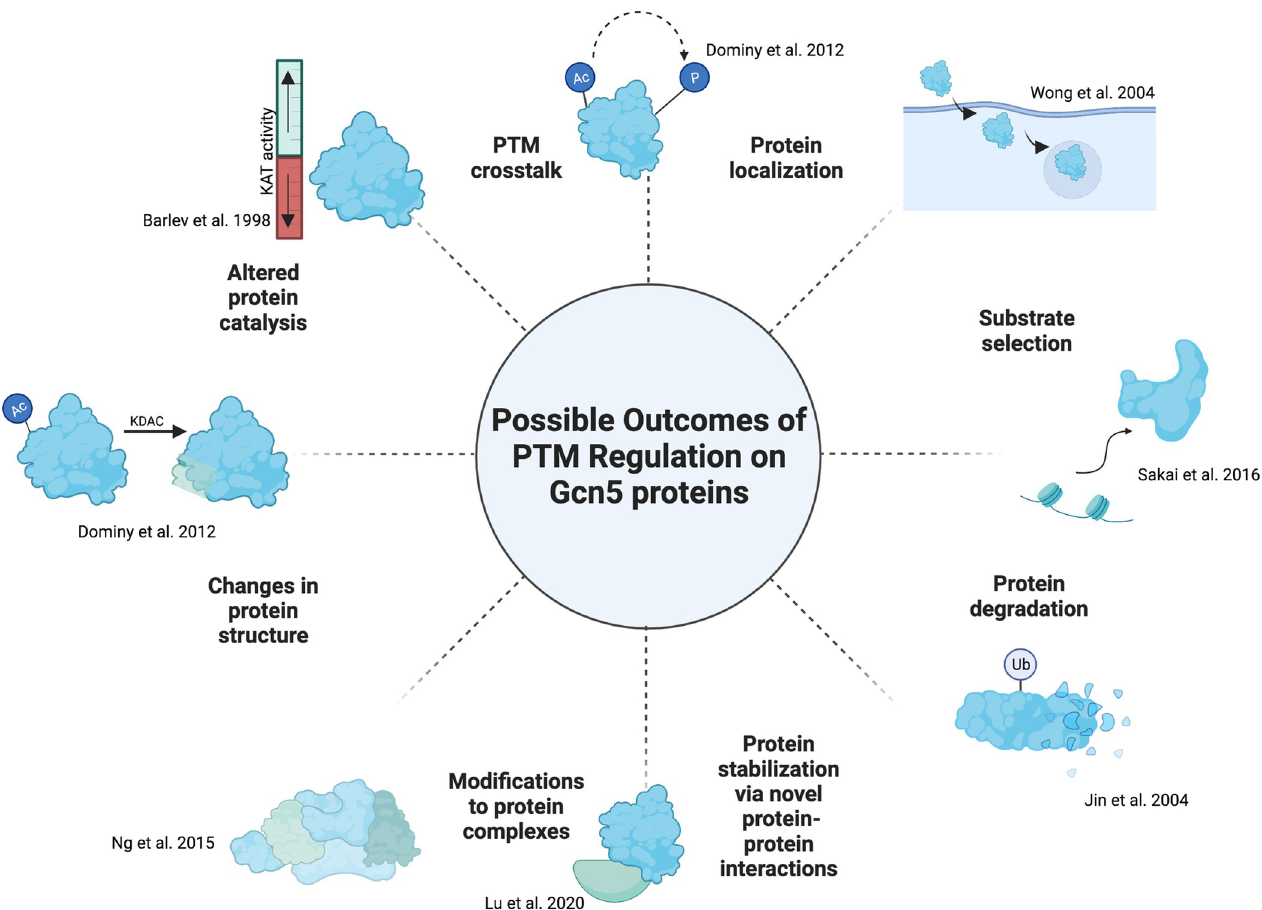
Fig 2. Molecular consequences for the modification of Gcn5 proteins. Overview of cellular processes impacted by the modulation of Gcn5 proteins activities. For details, see indicated studies [35,36,39,53,58,63,64].Adapted from “Circular Diagram with 8 Sections (Layout)”, by BioRender.com (2022). Retrieved